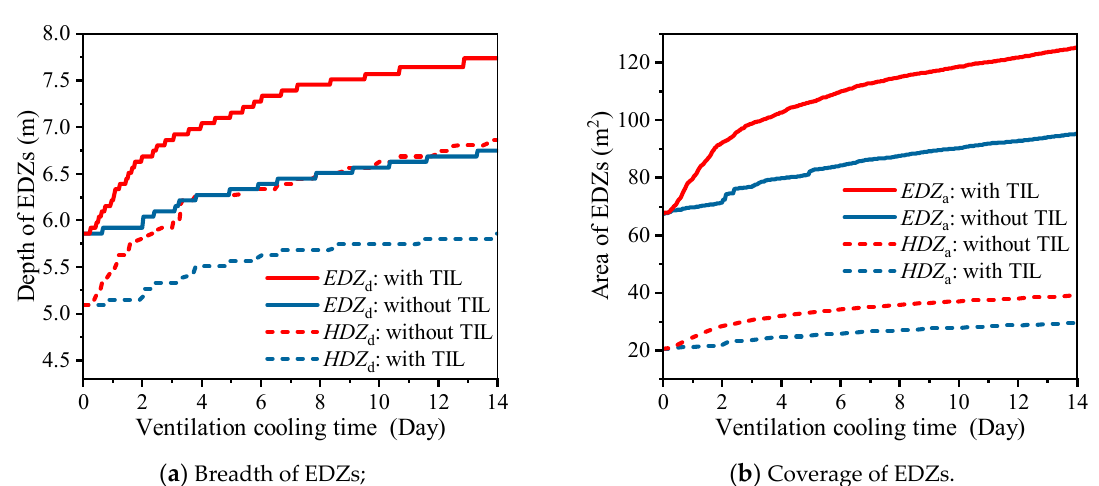
Figure 16. Evolution law of EDZs with the time of ventilating and cooling inside tunnel.